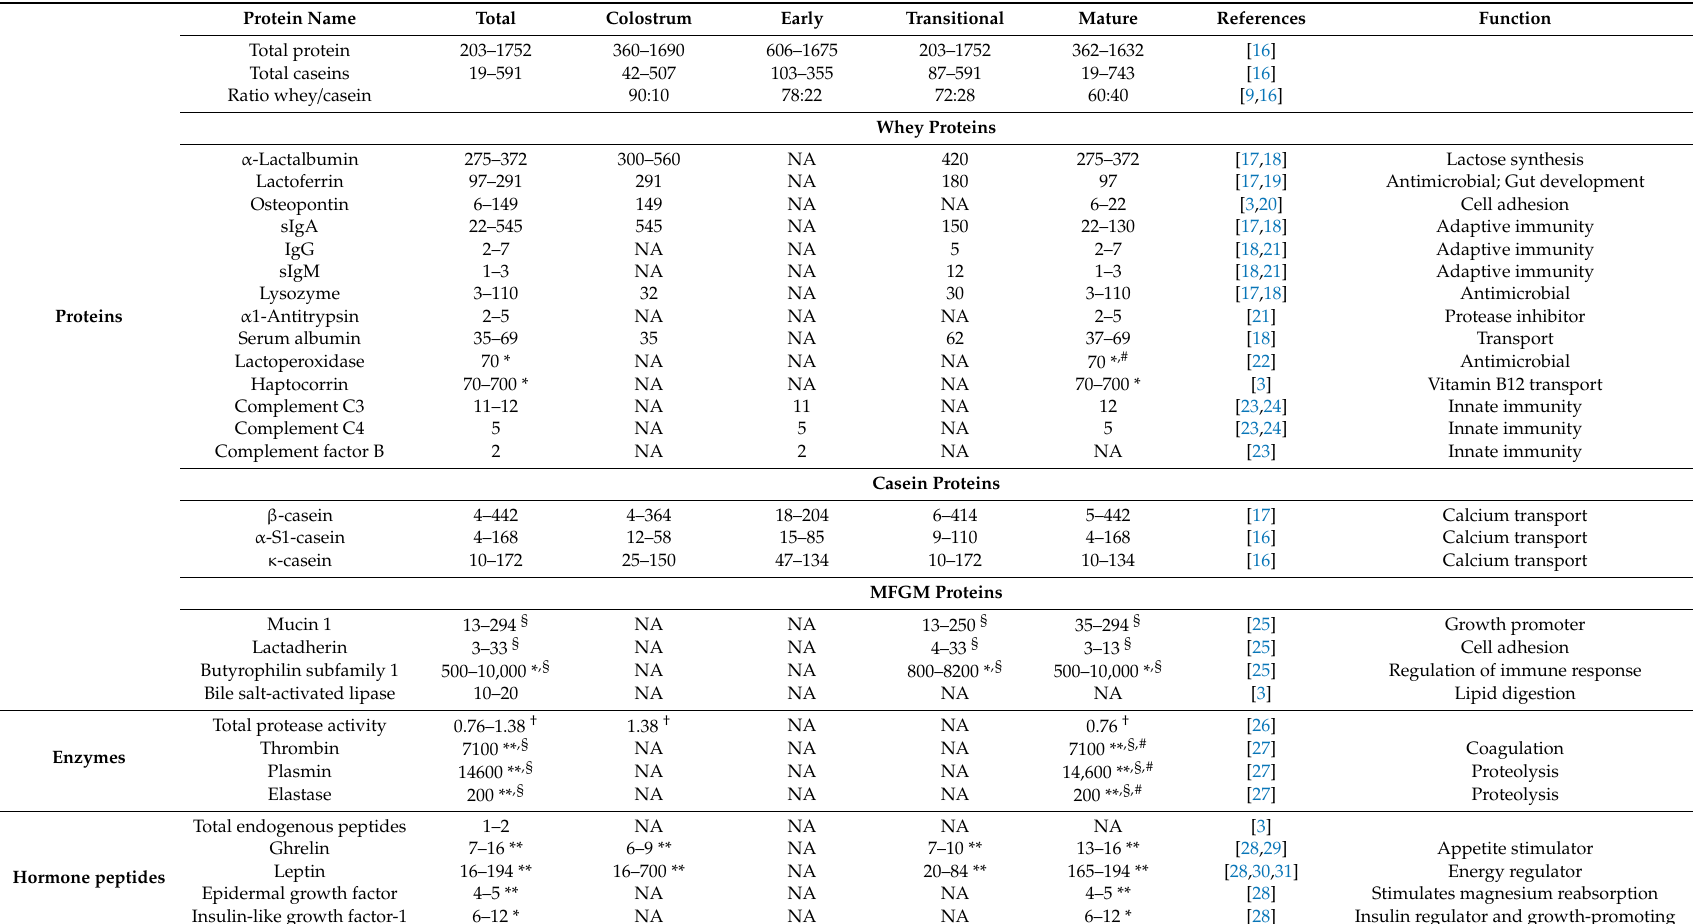
Table 1. Overview of reported human milk protein concentrations over lactation and